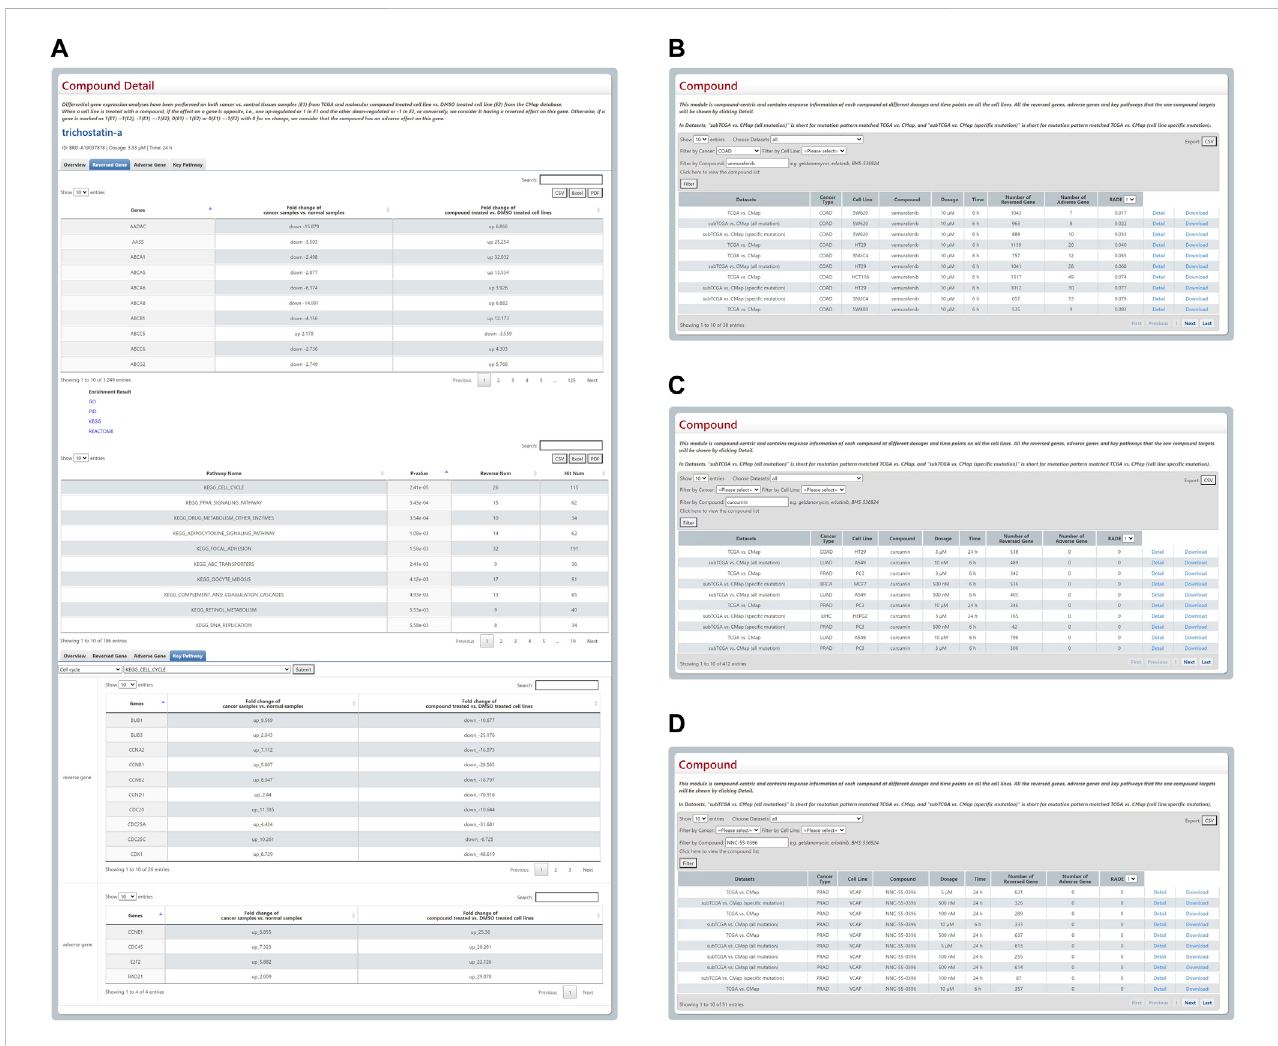
FIGURE 2 OutlineandstatisticalanalysisofCompoundmodule. (A) Thecompounddetailpageincludesconciseinformation,detailsofreversedandadversegenes, and pathway enrichment analysis. (B – D) Three responsive tables of users ’ search results have been employed to prove the rationality of the RADE scores raised by the